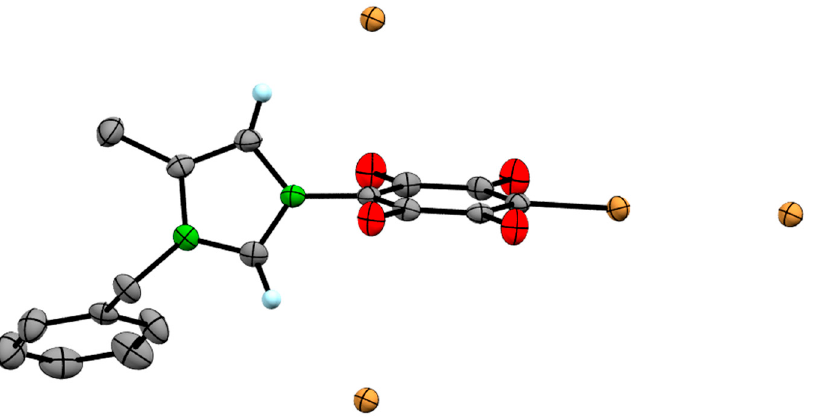
Figure 2. Structure of the cation of 1 indicating the positions of the closest bromide anions. Thermal ellipsoids are at the 50% level. Hydrogen atoms, except those involved in hydrogen bonding, are omitted for clarity.